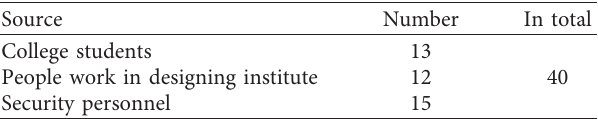
Figure 4: Evacuation scenario arrangement of the tunnel. Table 2: Form of experiment participants’